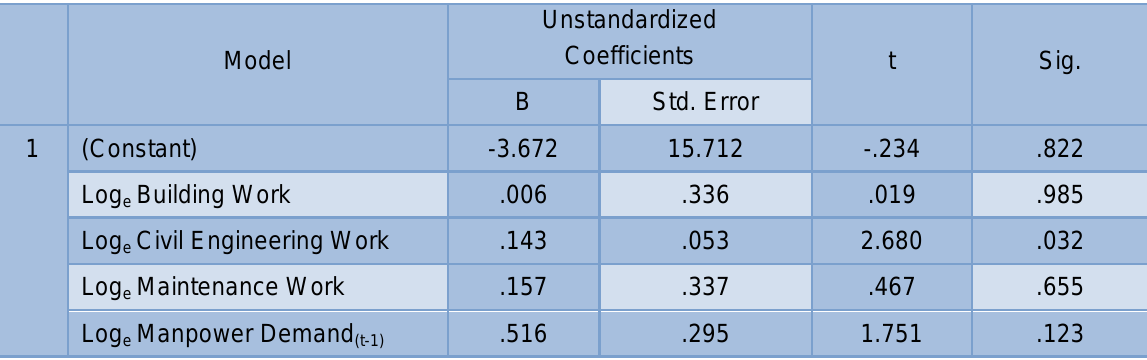
Table 4 Coefficients